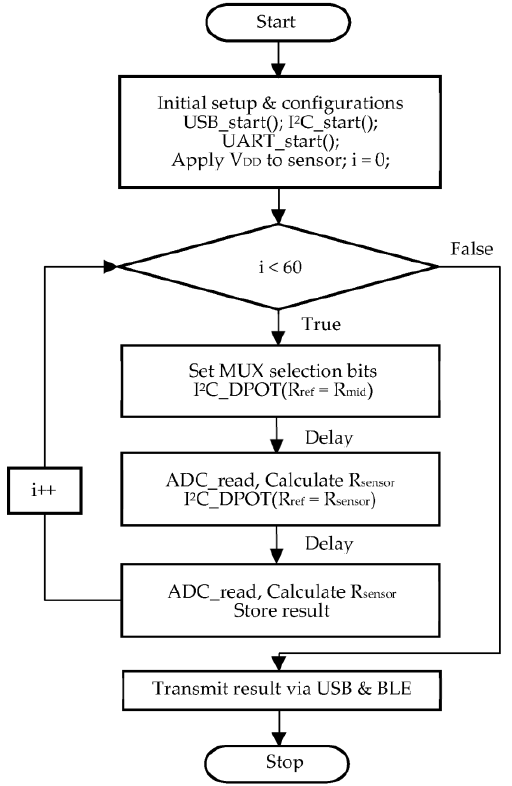
Figure 5. Flowchart of the proposed system.